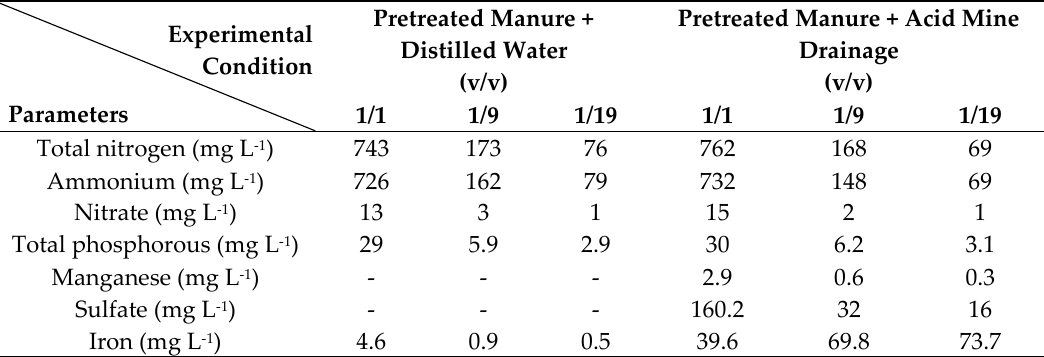
Figure 5. The effect of various mixing ratios between pretreated piggery wastewater by membrane (PPWM) and acid mine drainage (AMD) on the growth ( A ) and nutrients removal ( B ) of Uronema sp. KGE 3. Table 1. Experimental condition for studying the effect of mixture from Pretreated manure and acid mine drainage.